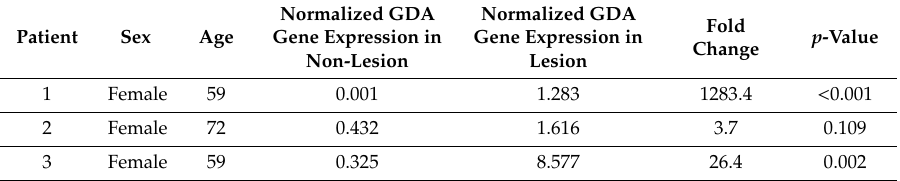
Table 1. The results of next generation sequencing for three patients with Riehl’s melanosis. Patient Sex Age